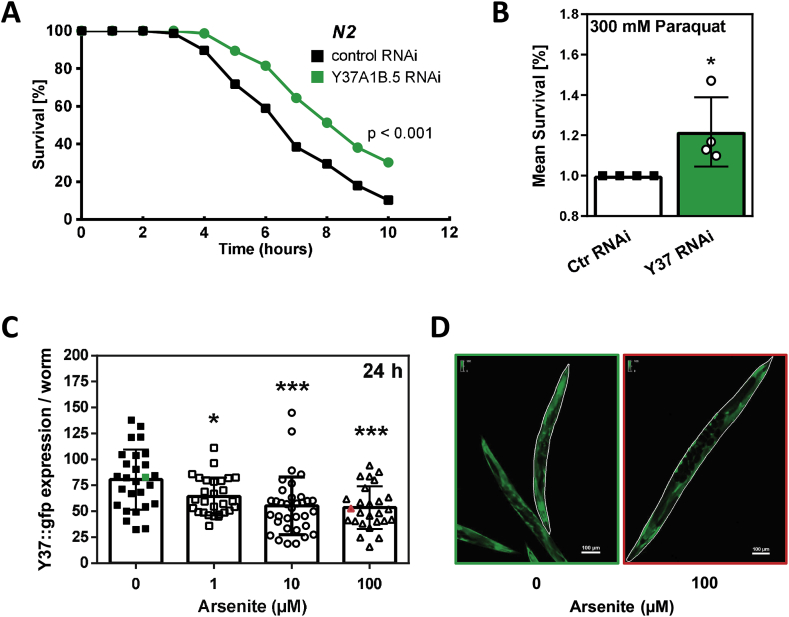
Y37A1B.5 is involved in the stress response of C. elegans. (A) N2 wildtype worms (young adult; 64 h after synchronization) were fed with Y37A1B.5 RNAi or control bacteria for 144 h and then exposed to 300 mM of paraquat for 10 h. Survival was scored every hour. (p vs. control, log-rank test). (B) Relative mean survival of Y37A1B.5 RNAi or control worms on 300 mM paraquat resulting from four independent experiments. Data were normalized to mean survival of control (*p<0.05 vs. control, Mann-Whitney test). (C) Y37A1B.5::GFP signals in young adult worms (64 h after synchronization) that were exposed to arsenite for 24 h. Each data point represents Y37A1B.5::GFP signal/worm in arbitrary units for one individual worm (*p<0.05, ***p<0.001; unpaired t-test). (D) Examples of worms evaluated in Fig. 4C (green, red data points), representing worms exposed to 0 μM (green box) and 100 μM (red box) arsenite.